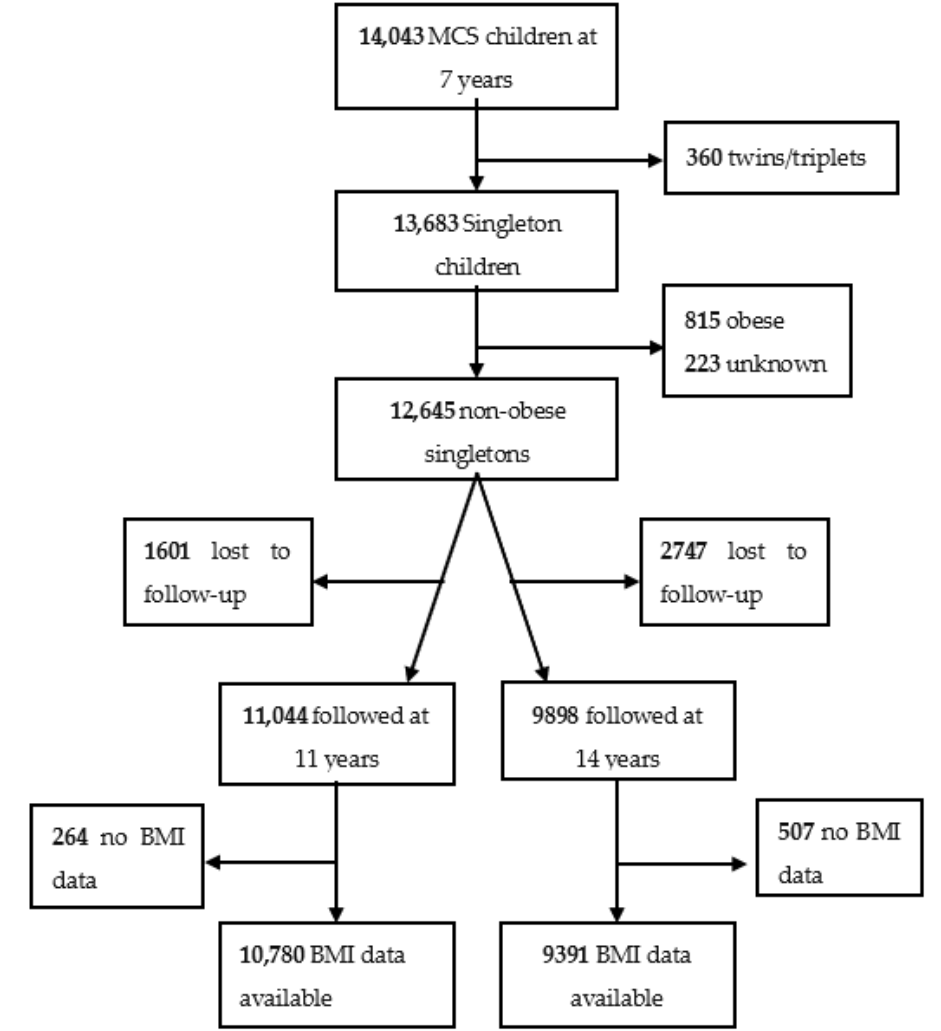
Figure 1. Participants’ follow -up flowchart.